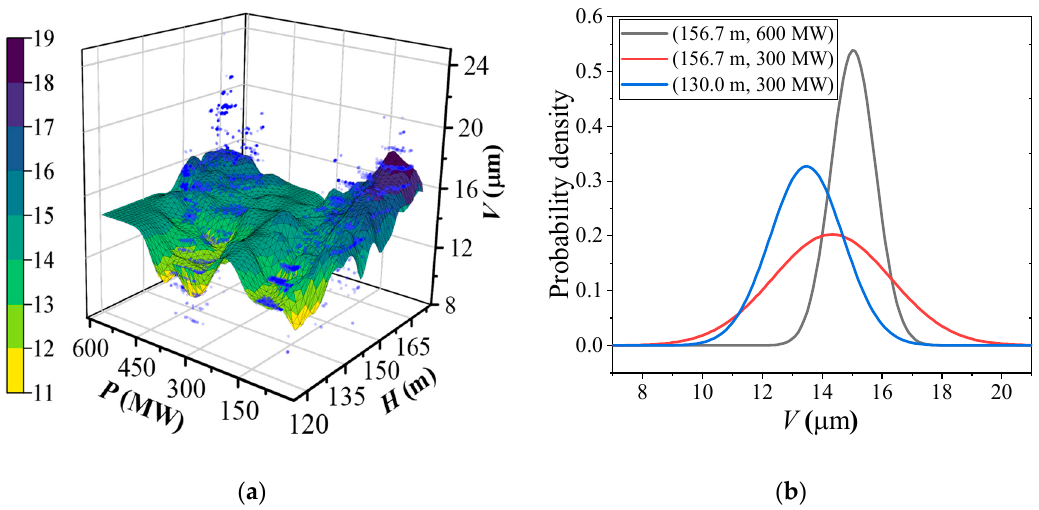
Figure 13. The healthy ‐ state model based on GPR: ( a ) the three ‐ dimensional surface of the mean value; and ( b ) the standard distribution at specific conditions.